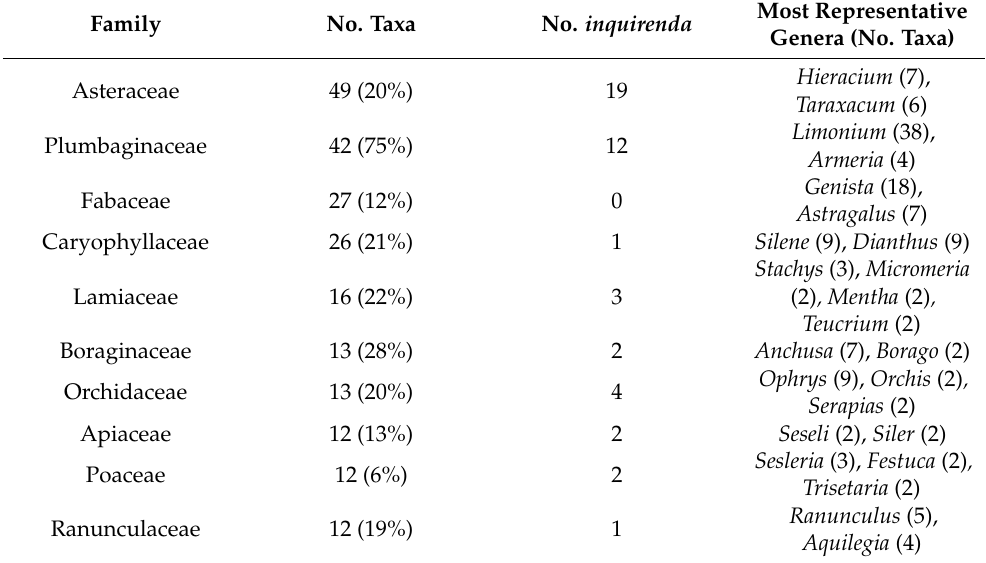
Table 1. Number of endemic vascular taxa (and their relative percentage of the total taxa of the native flora) of the ten richest families in endemic species. The two most species-rich endemic genera and their respective number of doubtful taxa (i.e., inquirenda ) are also reported for each family. Family No. Taxa No. inquirenda Asteraceae 49 (20%) 19 Plumbaginaceae 42 (75%) 12 Fabaceae 27 (12%) 0 Caryophyllaceae 26 (21%) 1 Silene (9), Dianthus (9) Lamiaceae 16 (22%) 3 Boraginaceae 13 (28%) 2 Anchusa (7), Borago (2) Orchidaceae 13 (20%) 4 Apiaceae 12 (13%) 2 Seseli (2), Siler (2) Poaceae 12 (6%) 2 Ranunculaceae 12 (19%) 1